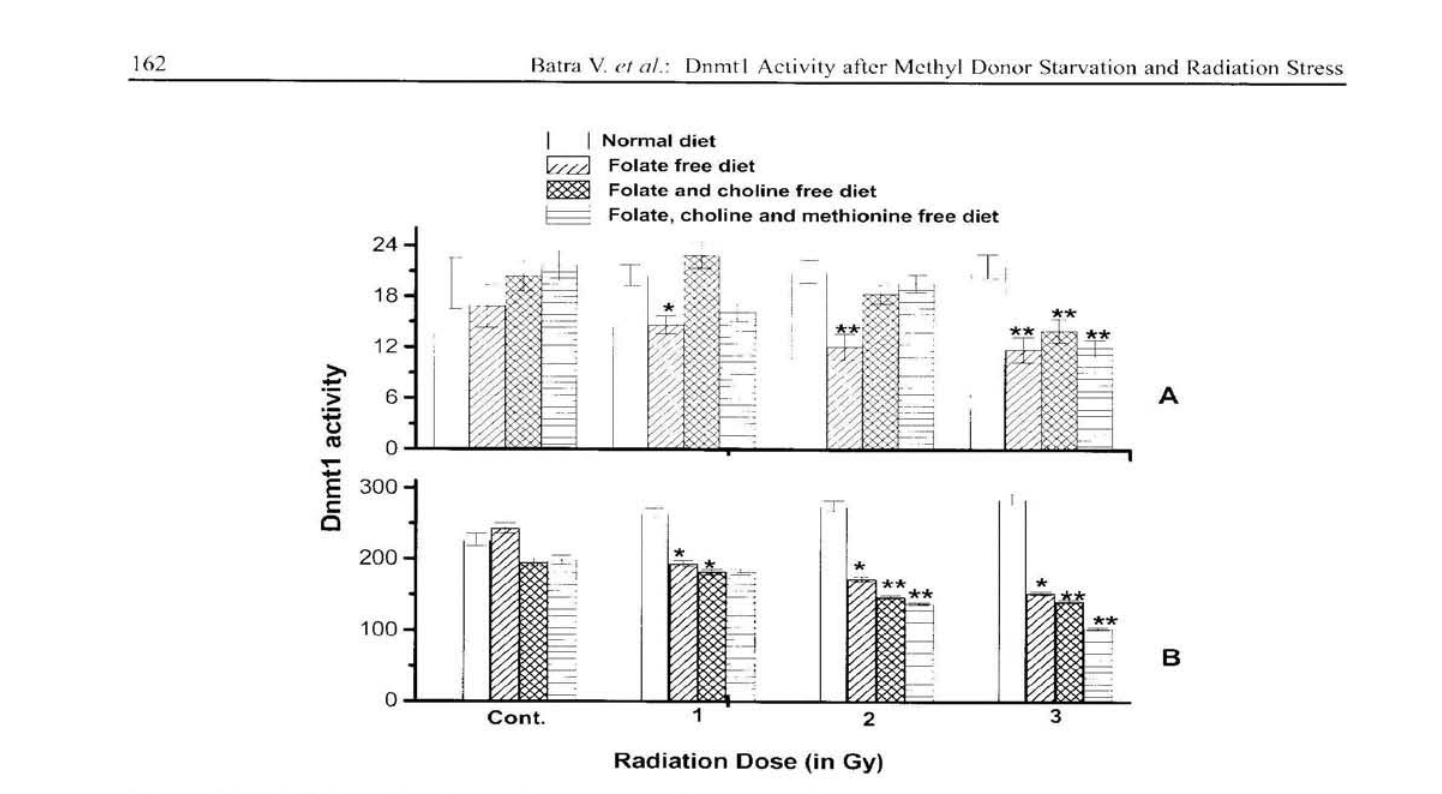
Figure 1. Modulation of nuclear and supernatant dnmtl activities by various doses of γ-irradiation followed by methyl donors starvation (Λ: Cytoplasmic dnmtl activity; B: Nuclear dnmtl activity). The activity is expressed as femtornole of methyl group transferred ^g protein/ hour and the values are mean ± standard error of samples (in triplicate) from 4 animals in each group (*P <0.05, **P <0.01 ).